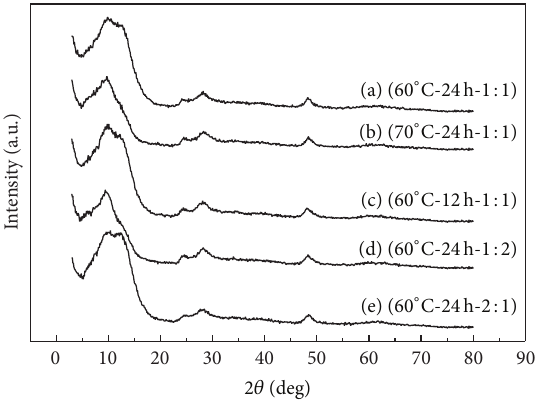
Figure 2: XRD patterns of